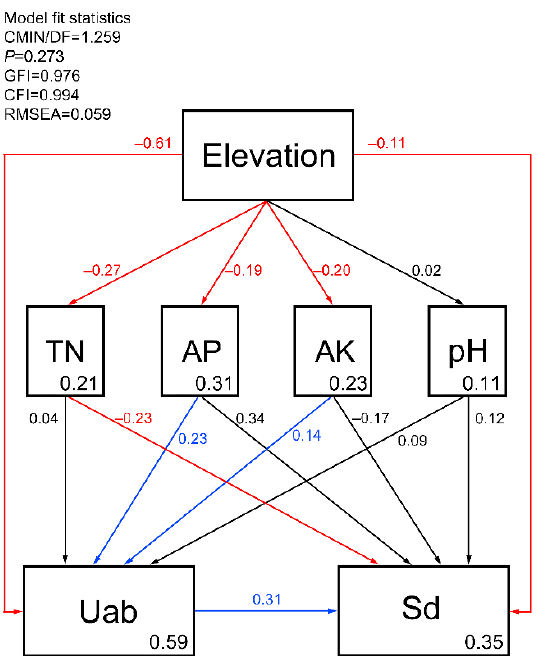
Figure 9. SEM showing the effects of the explanatory variables on species richness and density of the soil seed bank. A causal relationship is represented by arrows. Only the paths with significant influence ( p < 0.05) are shown to simplify the graph. Multiple R 2 are shown in the box of the respective response variable. Significant positive effects are indicated by blue lines and significant negative effects are indicated by red lines. Insignificant effects are indicated by black lines. TN—total nitrogen; AP—available phosphorus; AK—available potassium; Uab—abundance of understory vegeta- tion; Sd—soil seed banks density.